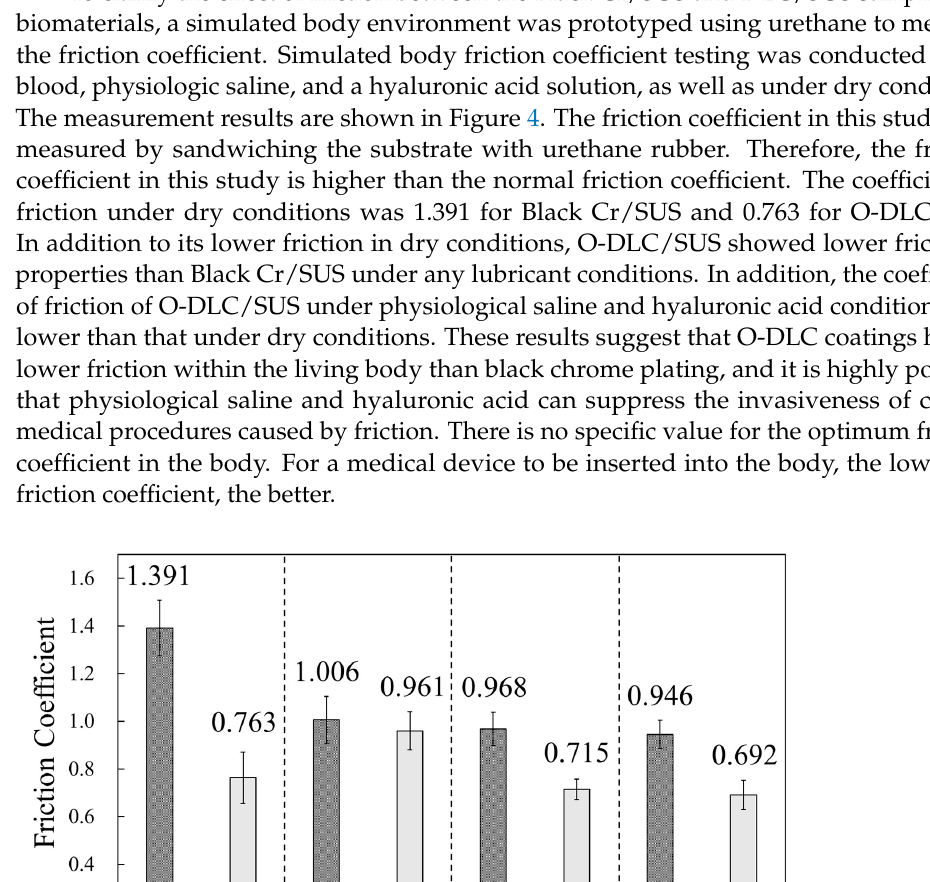
( b ) after Figure 5. X-ray photoelectron spectroscopy (XPS) spectra for diamond-like coating (DLC)/SUS ( a ) before and ( b ) after the immersion and sterilization tests.